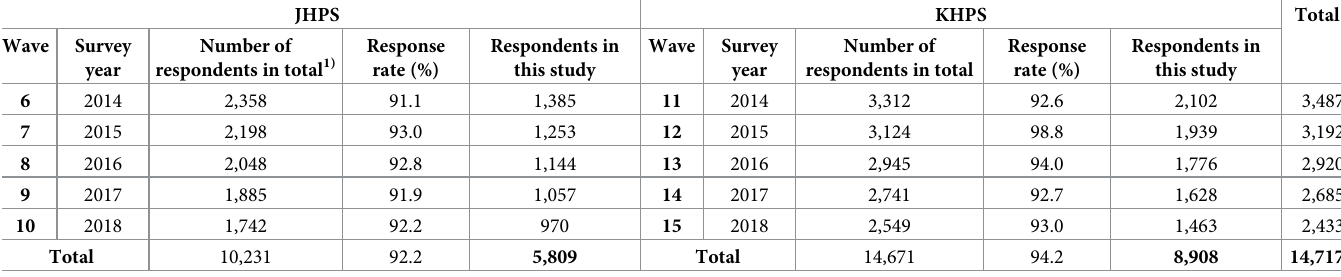
Table 1. The number of respondents and response rates for each survey and the number of recruited participants from each